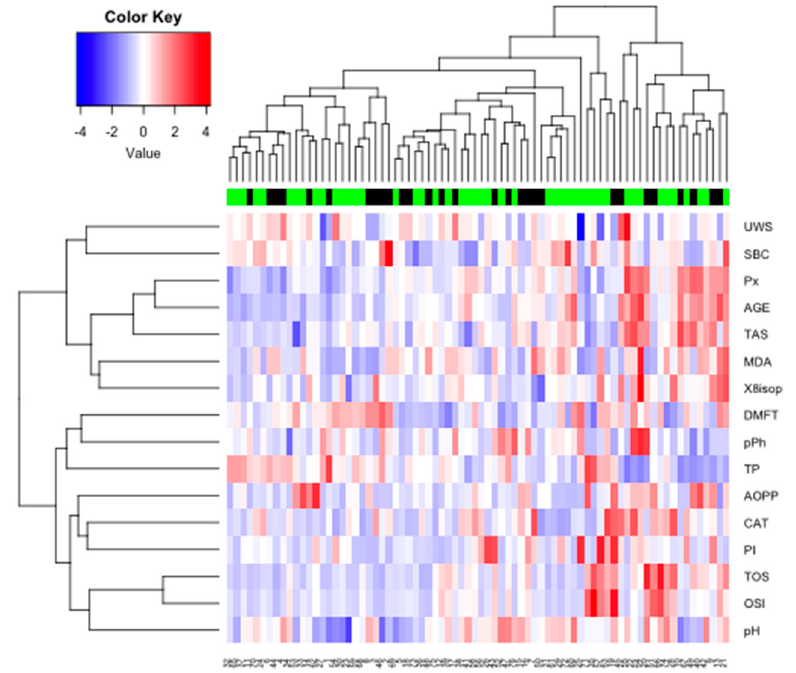
Figure 20. Heat map for all examined subjects. AOPP, advanced oxidation protein products; TP, total protein; OSI, oxidative stress index; TOS, total oxidant status; TAS, total antioxidant status; CAT, catalase activity; pPh, total phenolic content; Pl.I score, Plaque Index; DMFT, decay, missing, filled teeth; UWS, unstimulated whole saliva; SBC, salivary buffer capacity; 8-isop, concentration of 8-isoprostane; MDA, concentration of malondialdehyde; AGE, advanced glycation end-products; SBC, buffer capacity of saliva; Px, activity of salivary peroxidase.